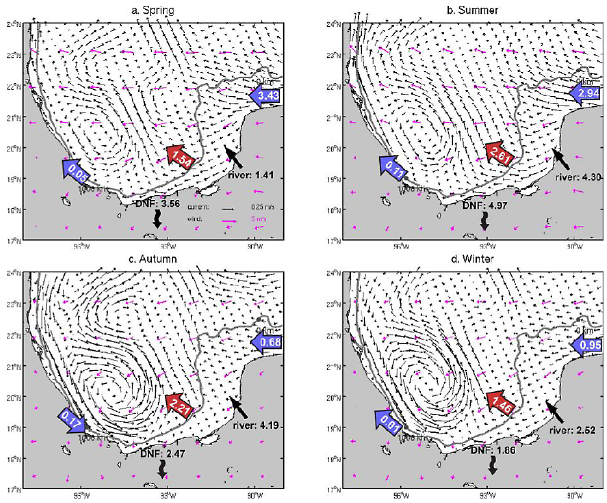
Fig. 12. Depth-integrated monthly mean cross-shelf (a) velocity, (b) DIN flux, (c) PON flux and (d) annual mean DIN and PON flux cross the 50m isobath. Positive/negative values stand for shore- ward/seaward transport.